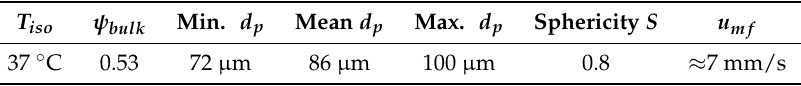
Table 2. Properties and working conditions for quartz